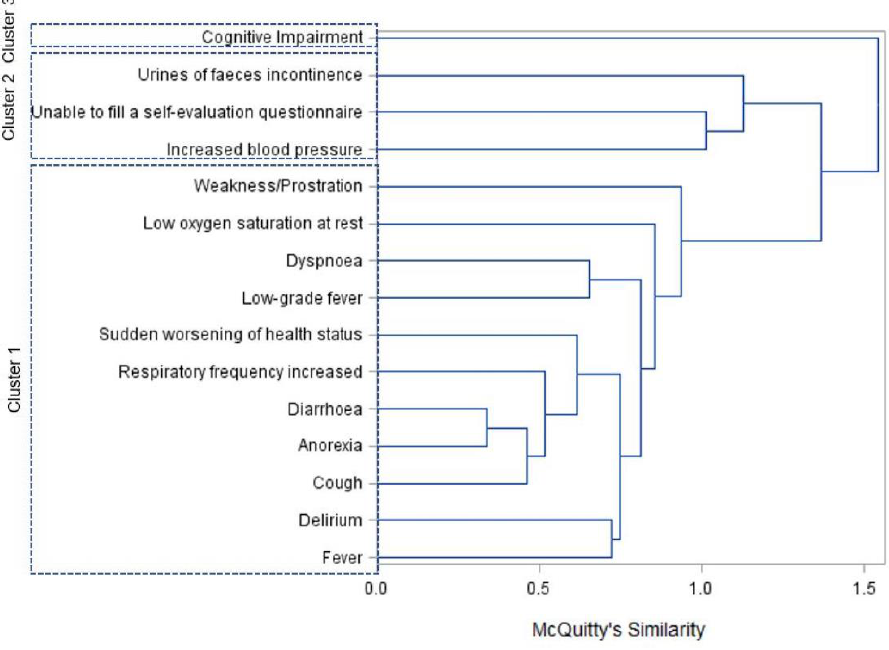
Figure 2. The dendrogram of symptom clusters (n = 503 participants independent of swab results; McQuitty method; only symptoms reported for 5% or more of the study participants were included).